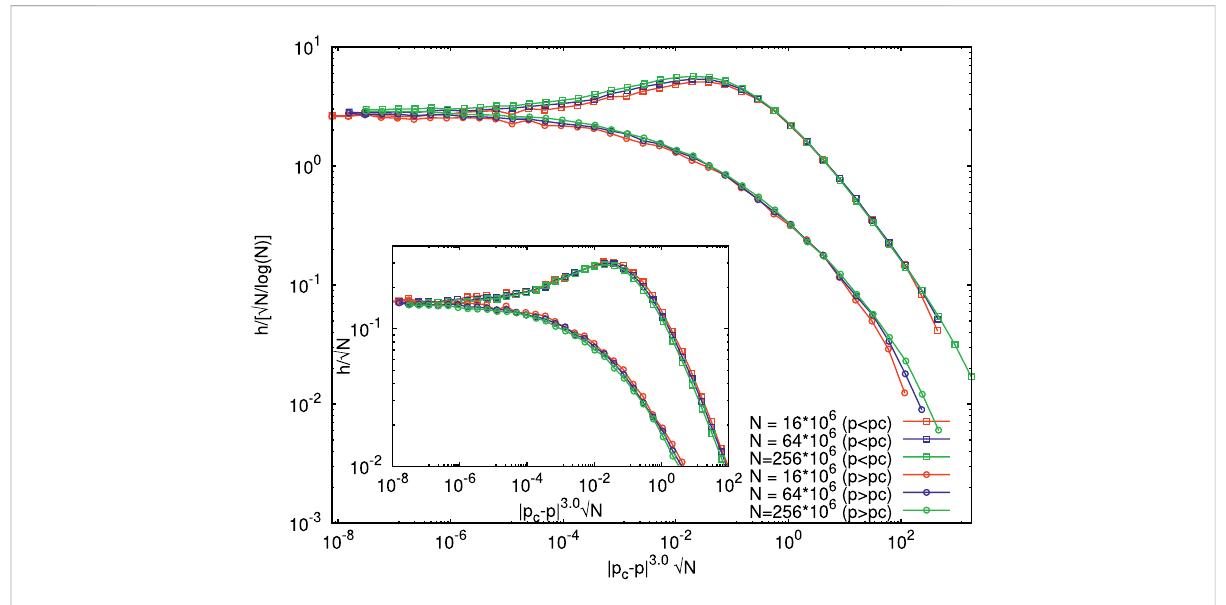
FIGURE 4 Finite size scaling analysis of the 2D site percolation h − index (from the cluster size distribution). The scaling fi t to the Widom – Stauffer relations (Eq. 1) is obtained by making all the data points of different sizes ( N =4000×4000,8000×8000, and 16000×16000) and concentrations (different p values, p c =0.5927)collapsetogether.Itturnsoutthatthescalingform(Eq.1b)withtheexponent α =3givesgooddatacollapse.Theinsetshowsthat the data collapse seems to get worsened by dropping the log N term in the scaling relation (Eq.